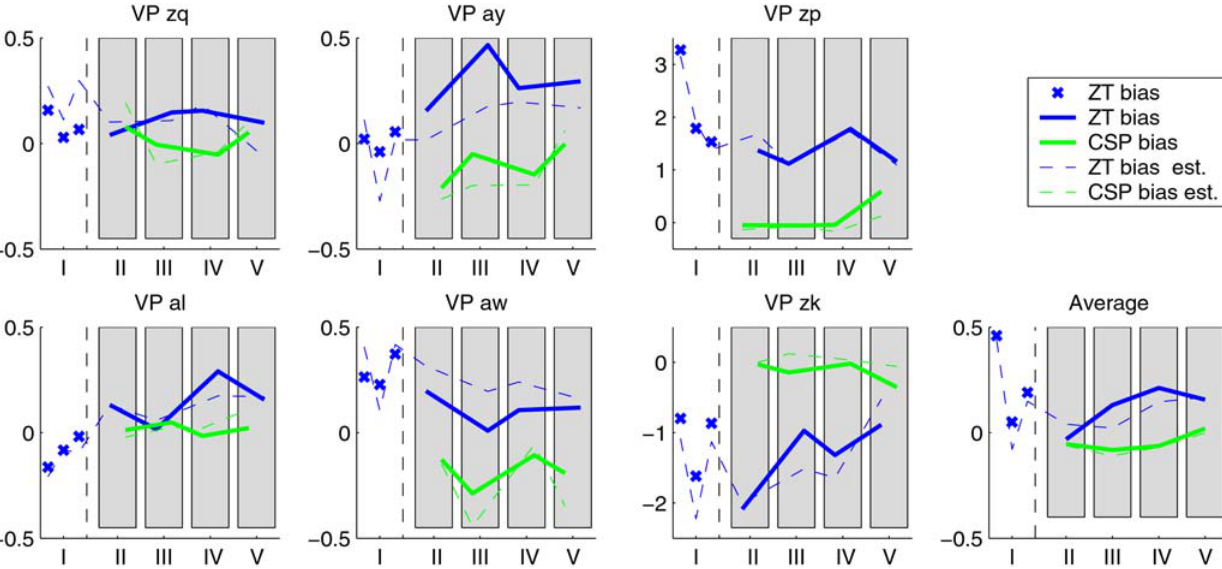
Figure 6. At the beginning of each run, the bias for the classifier was adapted using 10 trials per movement imagination class. The plot shows the optimal bias update, as calculated on the following 100 trials. This value is normalized by the difference between the classifier output class means. The solid lines show the optimal bias for CSP (green) and Zero-Training (blue) classifier separately. The dashed lines indicate the bias, as it was actually calculated on the initial 20 trials by the adaptation procedure during the feedback.